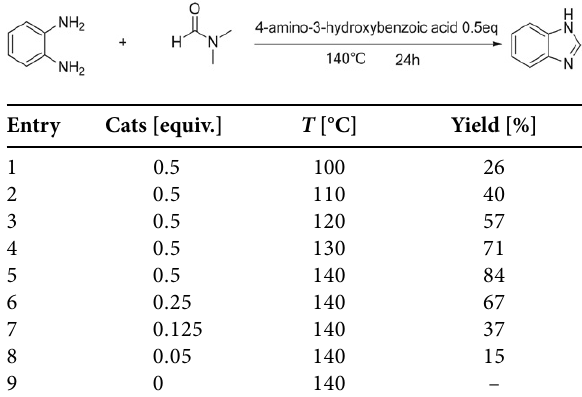
Table 1. The cyclization of o -phenylenediamine and DMF catalyzed by 4-amino-3-hydroxybenzoic